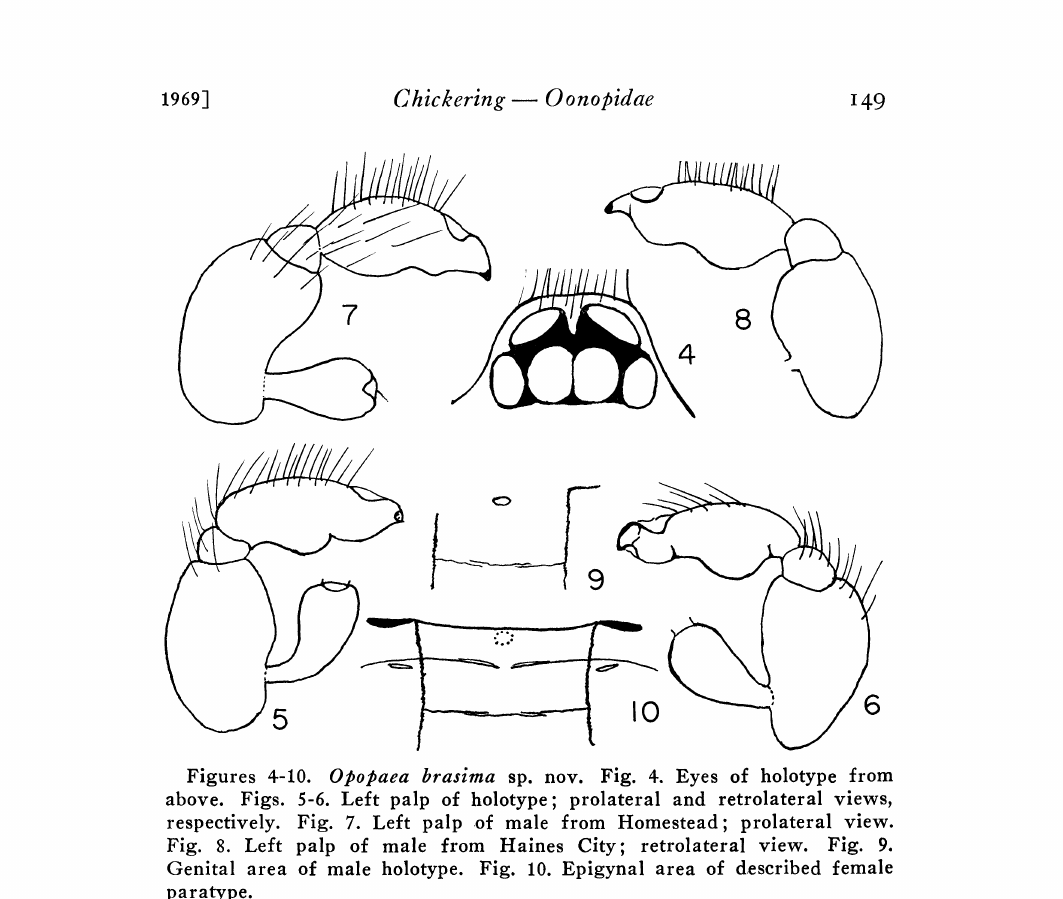
Figures 4-10. Opopaea brasima sp. nov. Fig. 4. Eyes of holotype from above. Figs. 5-6. Left palp of holotype; prolateral and retrolateral views, respectively. Fig. 7. Left palp .of male from Homestead; prolateral view. Fig. 8. Left palp of male from Haines City; retrolateral view. Fig. 9. Genital area of male holotype. Fig. 10. Epigynal area of described female